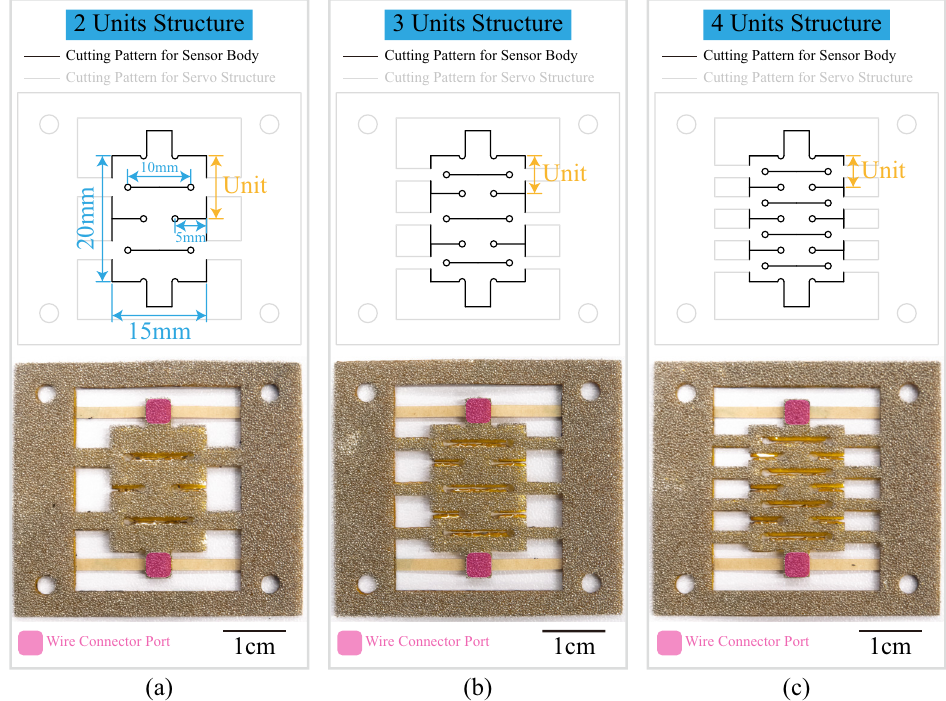
Figure 1. Kirigami-inspired cutting patterns (top) and photos of the wire connector ports (bottom) of sensors. ( a ) Sensors with two-unit kirigami structure; ( b ) Sensors with three-unit kirigami structure; ( c ) Sensors with four-unit kirigami